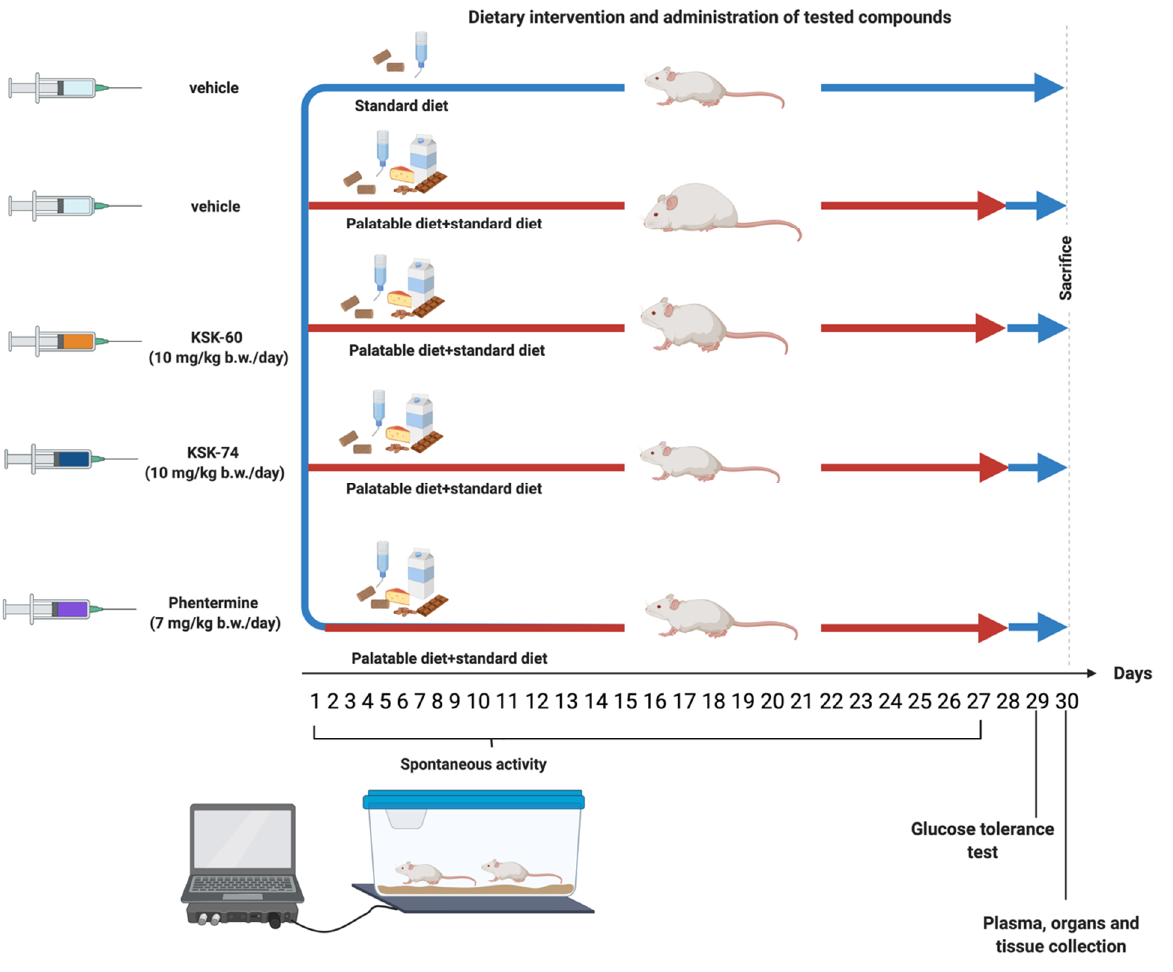
Figure 14. Experiment scheme.